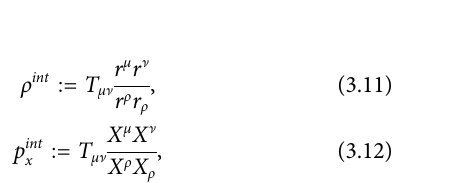
FIGURE 3 | The stress energy tensor of the effective metric ( 0 ) ~ g μ v ( x ) . This plot corresponds to δ x (cid:2) ℓ Pl , namely, s (cid:2)